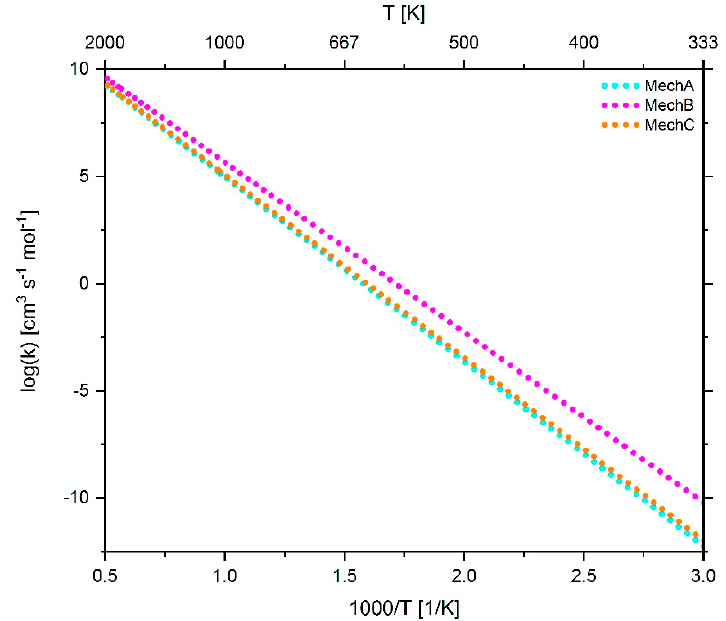
Figure 9. Comparison of the reaction rate coe ffi cient of reaction 302 ( n -C 7 -OQOOH ↔ OH + CH 2 O + CO + C 2 H 4 + n -C 3 H 7 ) of MechA to MechC.